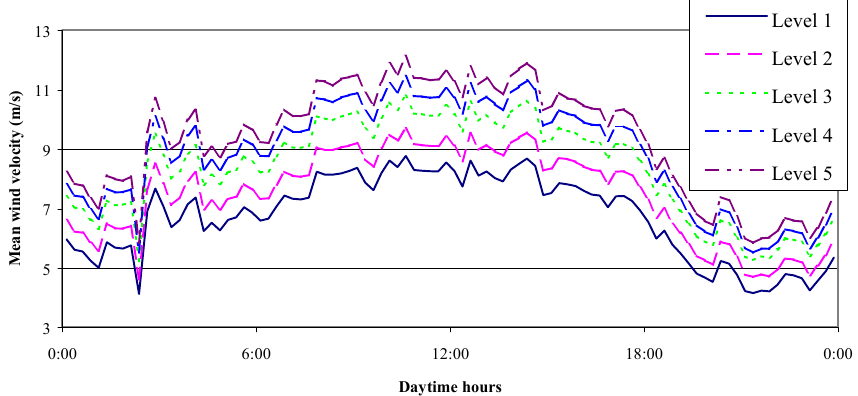
Fig. 2. Variation of the mean wind ve- locity during the day of 25 July 1997 at different